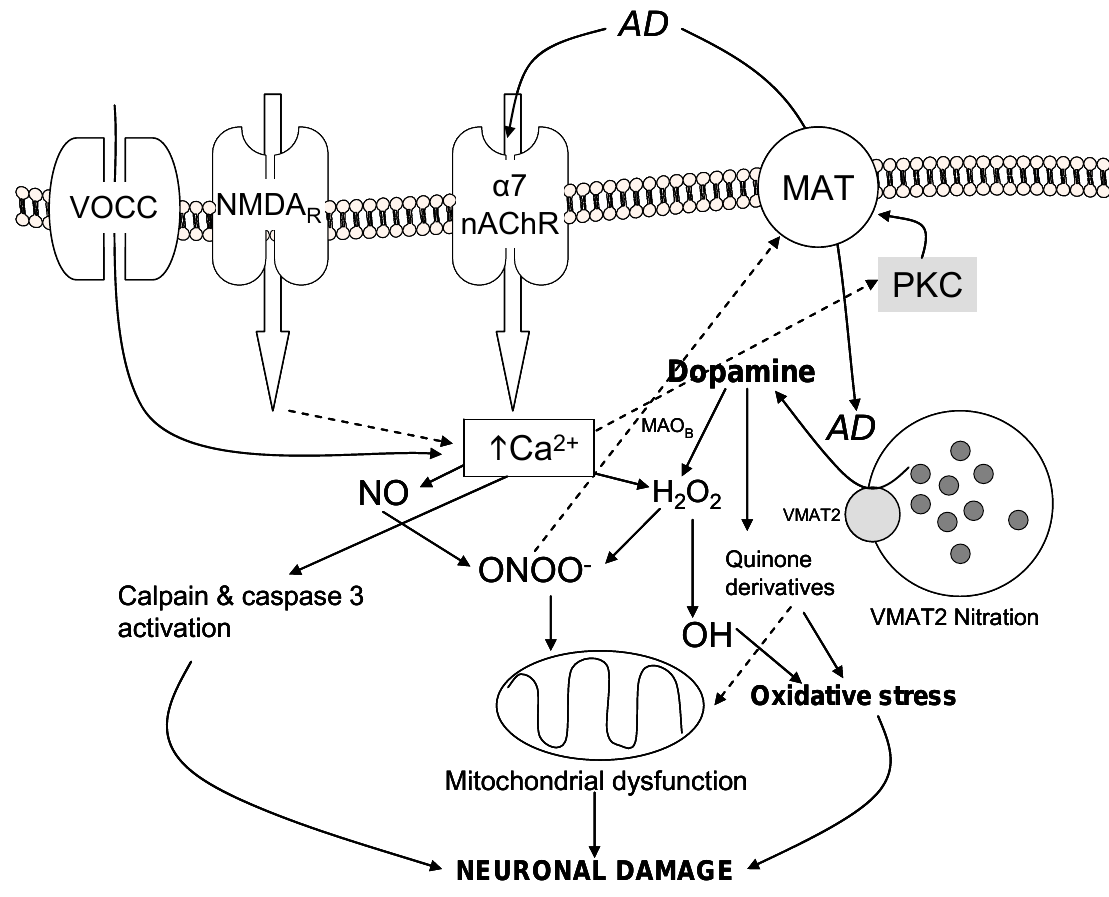
Figure 3. Schematic representation of the pathways involved in oxidative stress and neurotoxicity induced by amphetamine derivatives (AD). Activation of α 7 nAChR by AD contributes, together with other proposed pathways ( i.e. , NMDA receptor activation [61,71]), to a raise in intracellular Ca 2+ which results in activation of nNOS and production of NO. NO can produce ONOO − by reacting with superoxide. ONOO − induces direct damage to cell structures and induces mitochondrial dysfunction leading to metabolic impairment and cytotoxicity. Also ONOO - induces nitration of the plasmalemmal and vesicular monoamine transporters (MAT and VMAT, respectively). Ca 2+ also activates calpain and caspase 3 (see section 7.2), which are involved in proteolysis and cell death mechanisms, as well as PKC, which is related to MAT blockade trapping DA inside the terminal. At the same time, AD induce increase in free intracellular DA that can be metabolised by MAO O and superoxide which in turn can be further converted via the Fenton reaction to H 2 2 hydroxyl radicals that contribute to oxidative stress. Also dopamine can be metabolised to reactive quinone derivatives which contribute to cell function impairment [60]. Finally additional cytosolic Ca 2+ can enter after depolarisation through voltage-operated calcium channels (VOCC) or can be released from the endoplasmic